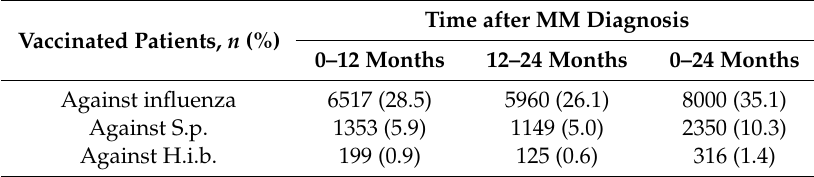
Table 3. Details of vaccinated patients for the study period (24 months after MM